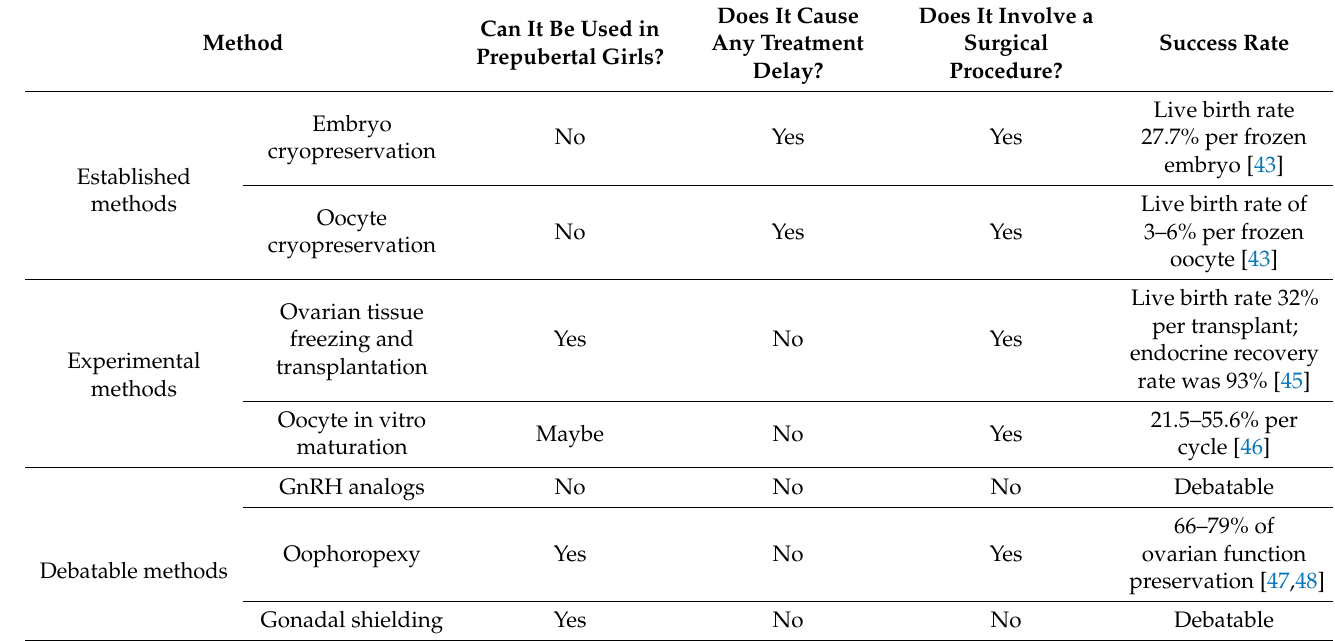
Table 3. Options for fertility preservation in girls undergoing cancer treatment